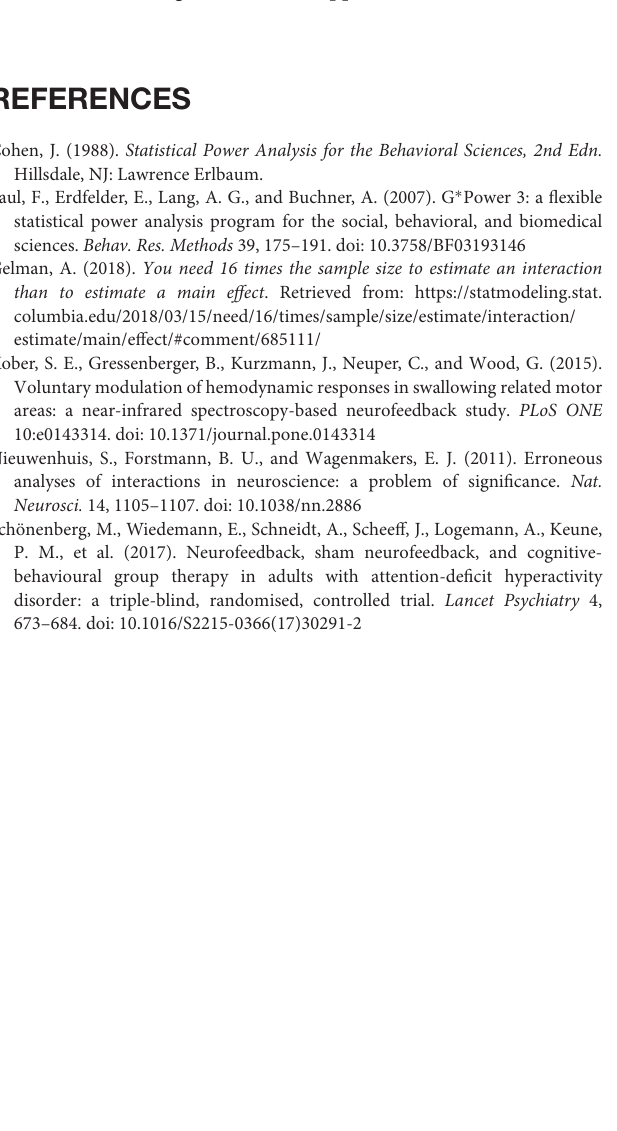
Figure 4. Statistical power curves to detect different effect sizes with 20 participants (median sample size) for different statistical tests.